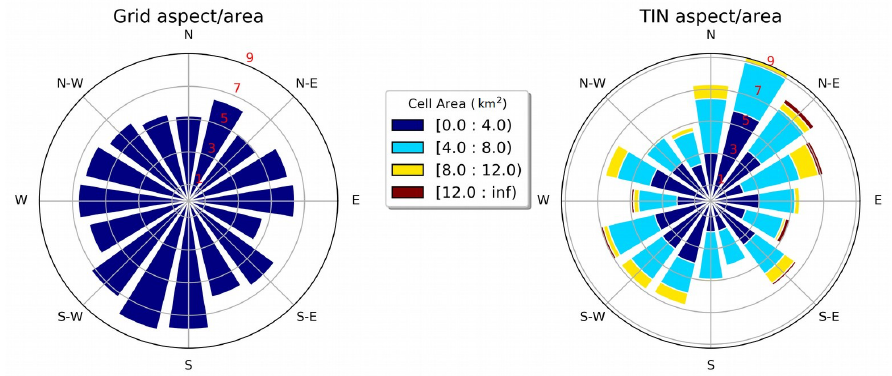
Figure 5. Cell area distribution with respect to aspect. Numbers in the radius stands for percentage area for respective aspect.